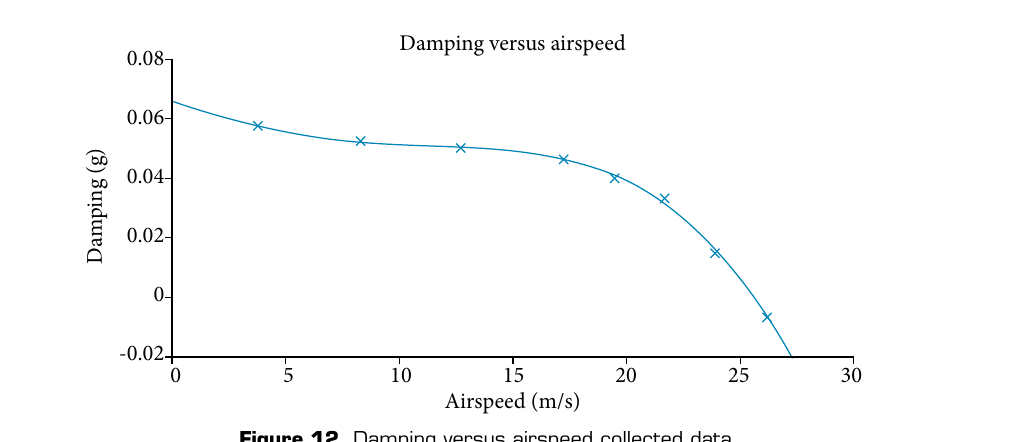
Figure 12. Damping versus airspeed collected data.